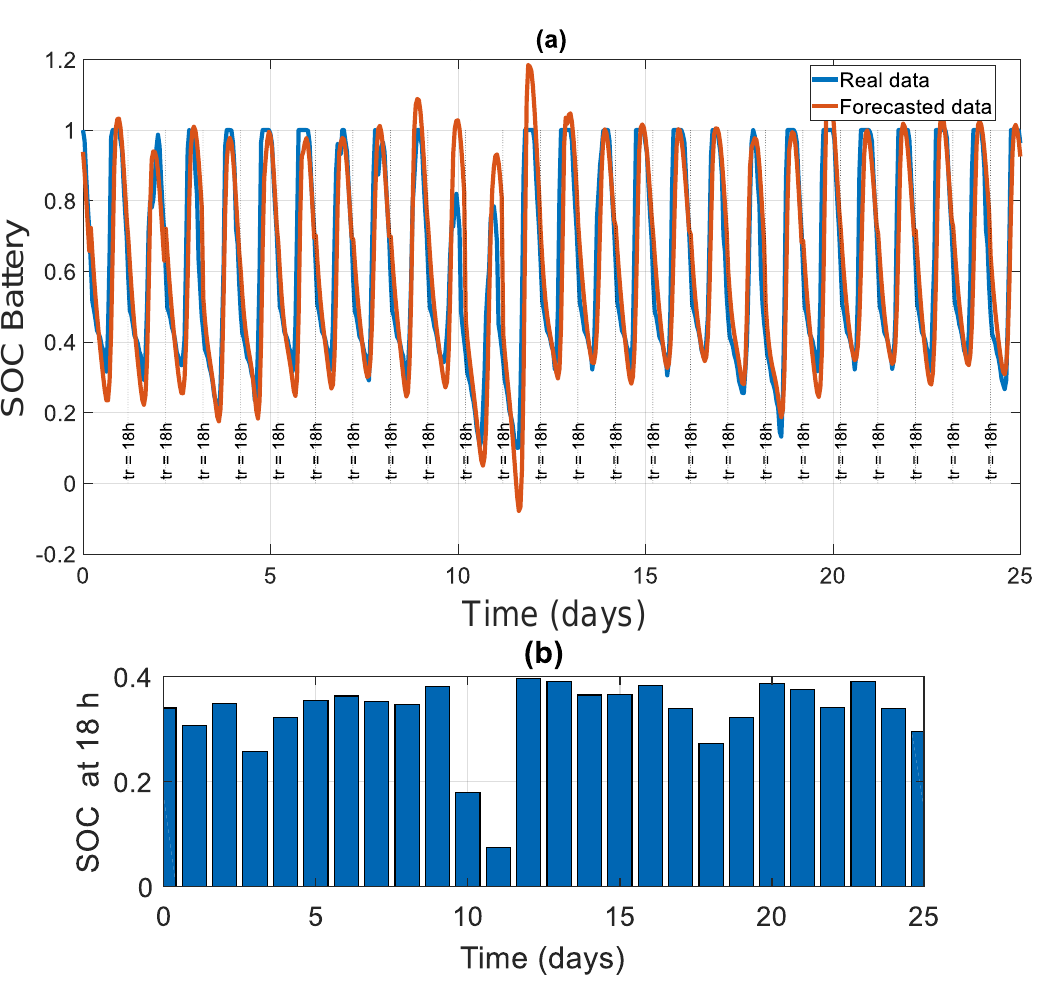
Figure 9. Battery SOC forecasting results over 25 days using LSTM network: ( a ) battery SOC real and forecasted data; ( b ) forecasted battery PSOC at tr = 18 h00.